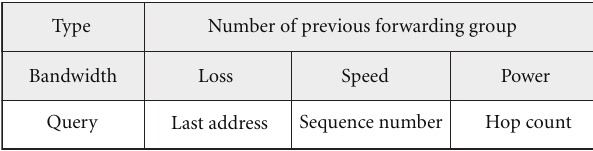
Figure 3: Structure of Join Query